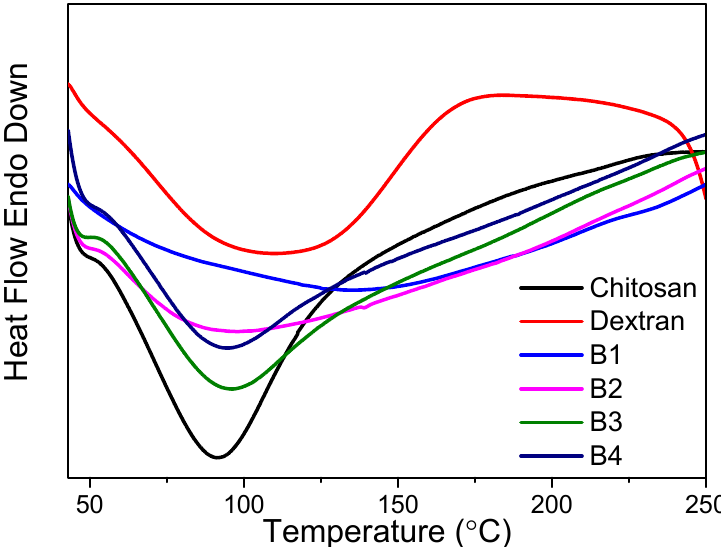
Figure 4. DSC thermograms of dextran, chitosan, and their nanocomposites.